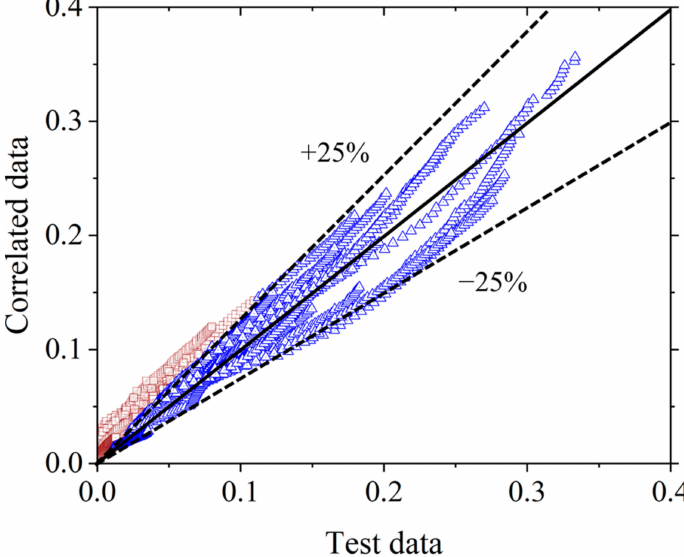
Figure 14. Comparison of test and correlated data for dimensionless frost